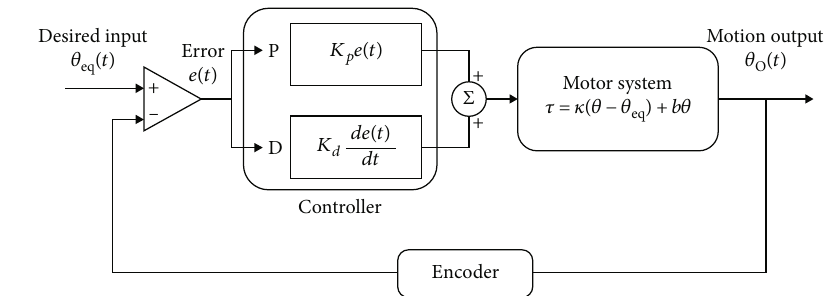
Figure 11: PD controller for the knee motion control.